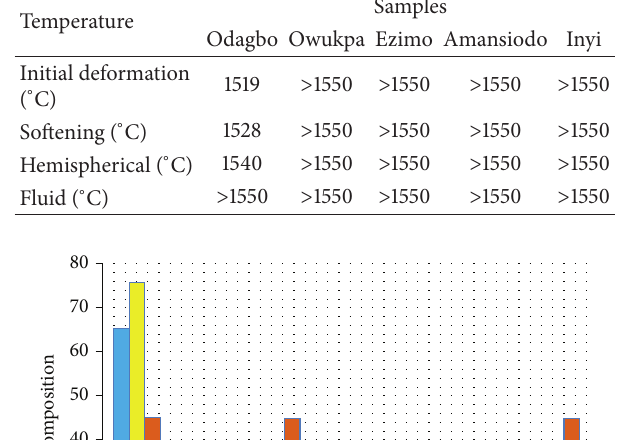
Table 4: Results of ash composition tests of the five coal samples. Constituents